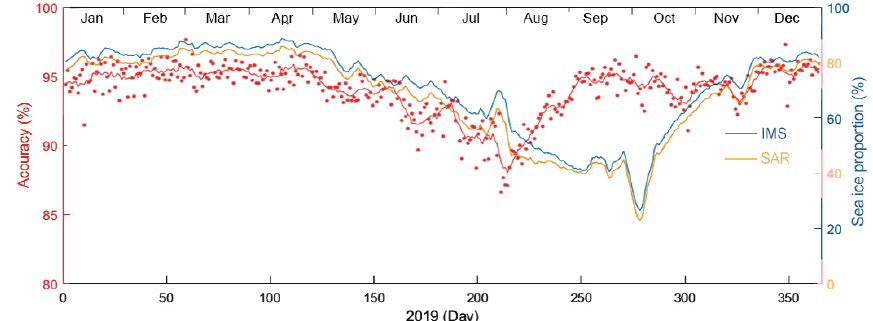
Figure 14. Comparison between the S1-derived Arctic sea ice cover product and the IMS data for the whole year of 2019. The red dots represent the daily average accuracy, and the red line is the 7d average accuracy. The blue line is the 7d average sea ice proportion in the S1-covered area calculated based on the AMSR2 data, and the orange line is the 7d average sea ice proportion calculated based on S1-derived results.